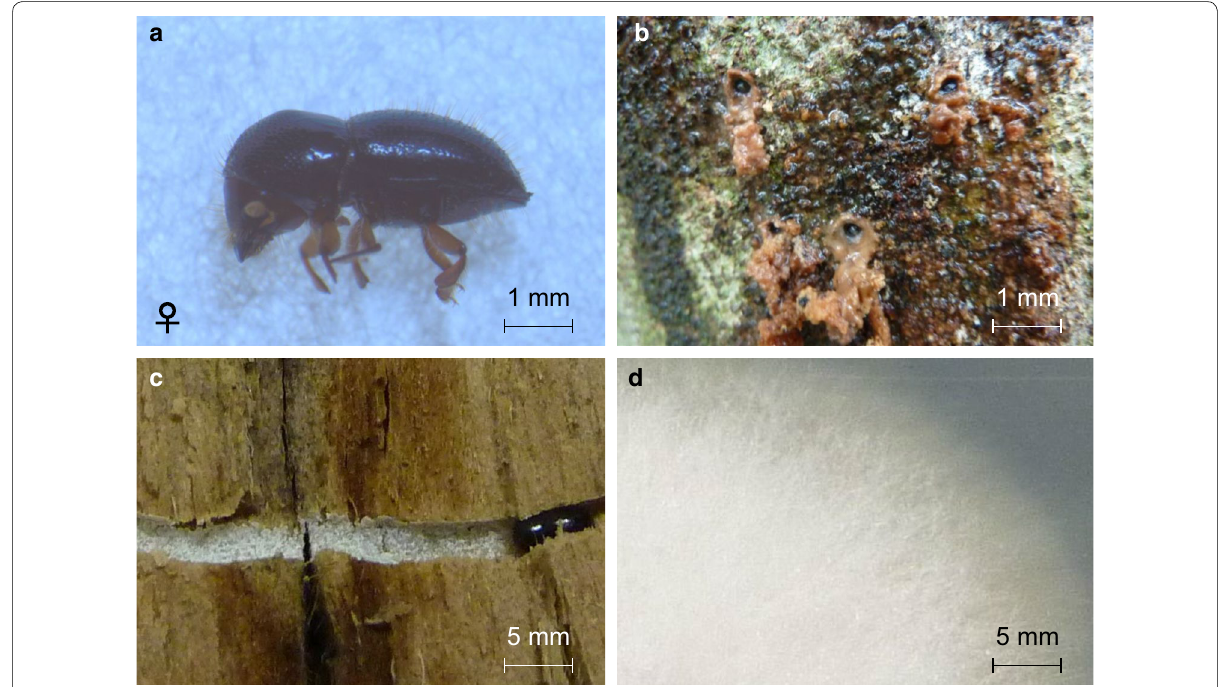
Fig. 1 Photographs of fungus cultivation by Euwallacea interjectus in Ficus carica. a Adult female E. interjectus . b Entrance holes of E. interjectus boring into the F. carica trunk. c Ambrosia fungi on the walls of a tunnel excavated by E. interjectus . d The fungal mycelia grown on a PDA